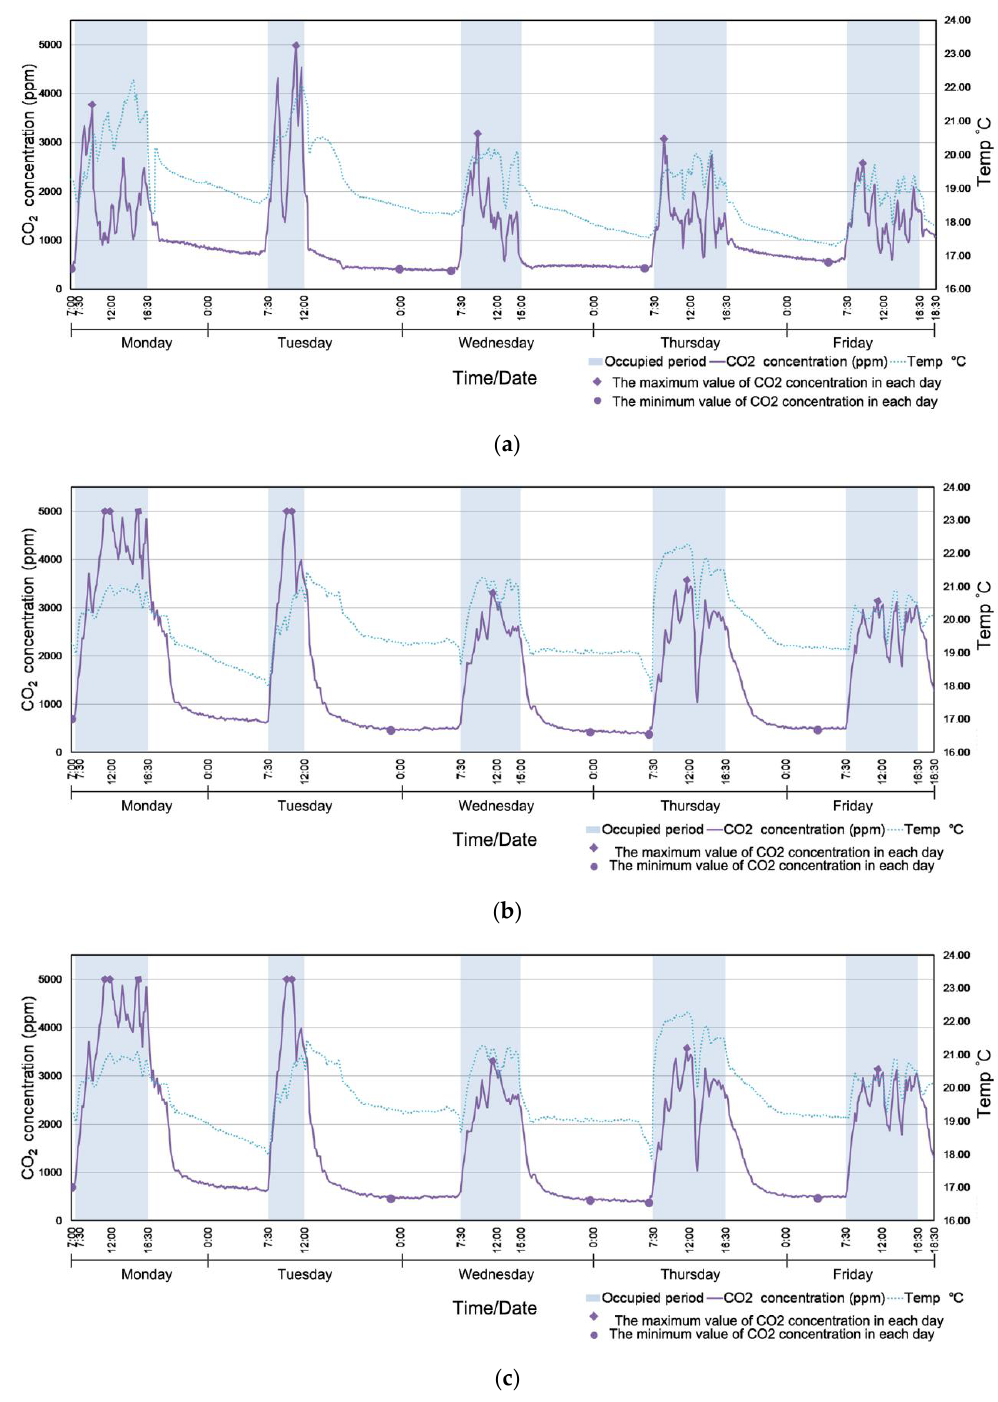
Figure 5. CO 2 concentration and temperature values in S1( a ), S2( b ) and N1( c ) between the 7th and the 11th of March 2016 (the shadowed areas correspond to the occupied periods).